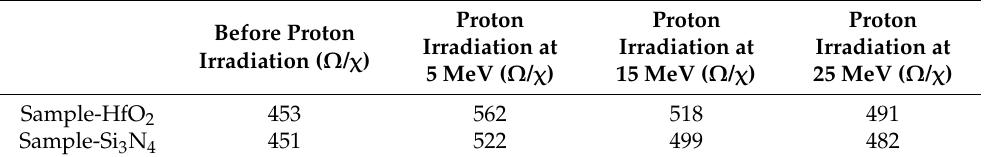
Table 1. Extracted sheet resistance before and after proton irradiation in GaN-based MIS-HEMTs for the 5 nm-thick HfO 2 and the Si 3 N 4 gate insulator. Proton Proton Proton Before Proton Irradiation at Irradiation at Irradiation at Irradiation ( Ω / χ ) 25 MeV ( Ω / χ ) 15 MeV ( Ω / χ ) 5 MeV ( Ω / χ ) Sample-HfO 2 453 562 518 491 Sample-Si 3 N 4 451 522 499 482